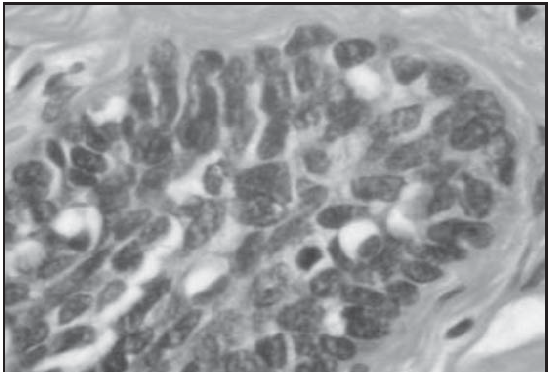
PINTO, A. P. & MAIA, L. R. Carcinoma adenoescamoso do colo uterino mimetizando carcinoma adenóide basal: relato de um caso e revisão da literatura (cid:127) J Bras Patol Med Lab (cid:127) v. 43 (cid:127) n. 1 (cid:127) p. 45-50 (cid:127) fevereiro